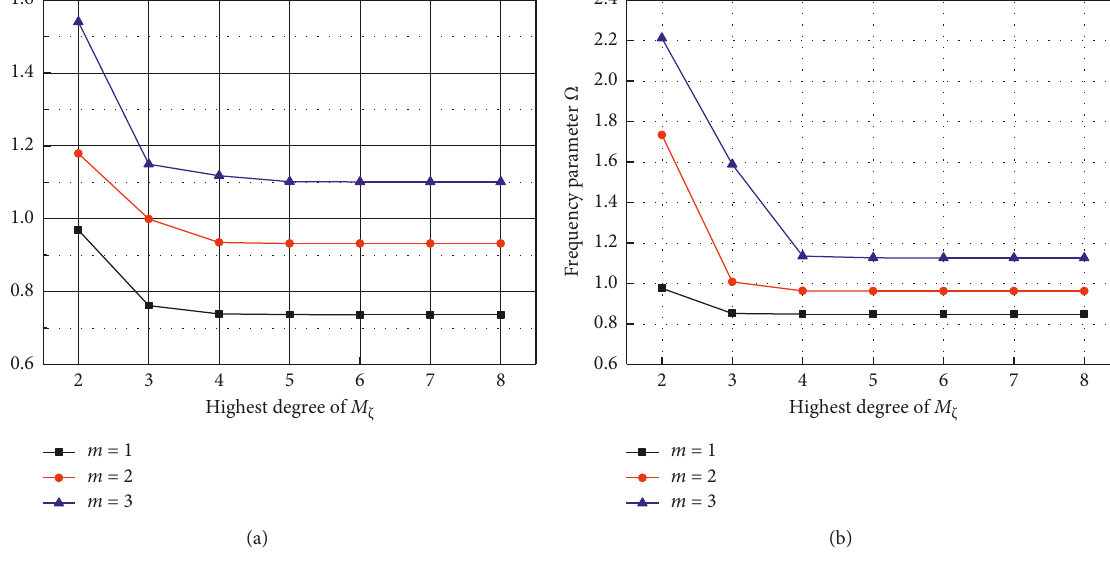
of FG spherical shell with different truncation. (a) n Ω